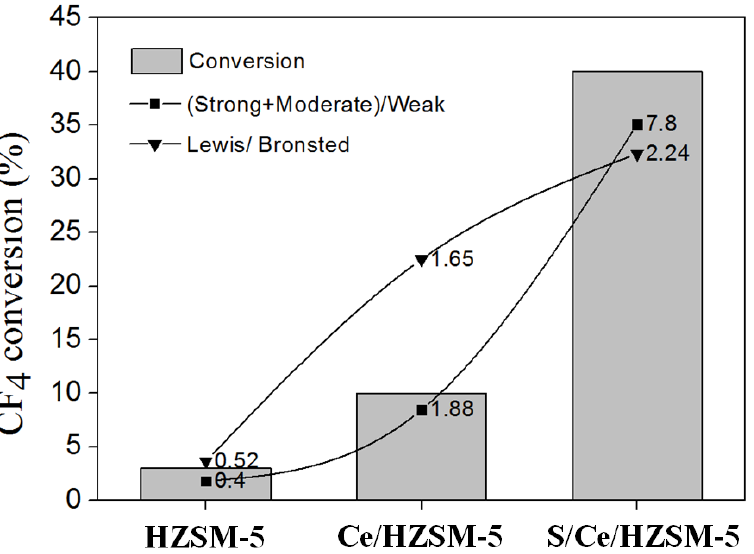
Figure 7. Correlation between CF 4 conversion and ratio of (strong + moderate)/weak and Lewis/Brønsted.